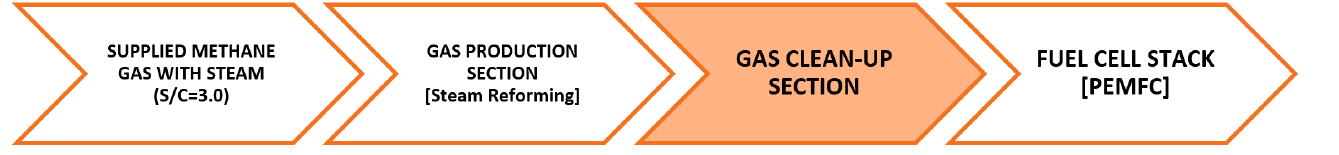
Figure 1. Schematic of methane reforming PEMFC system.